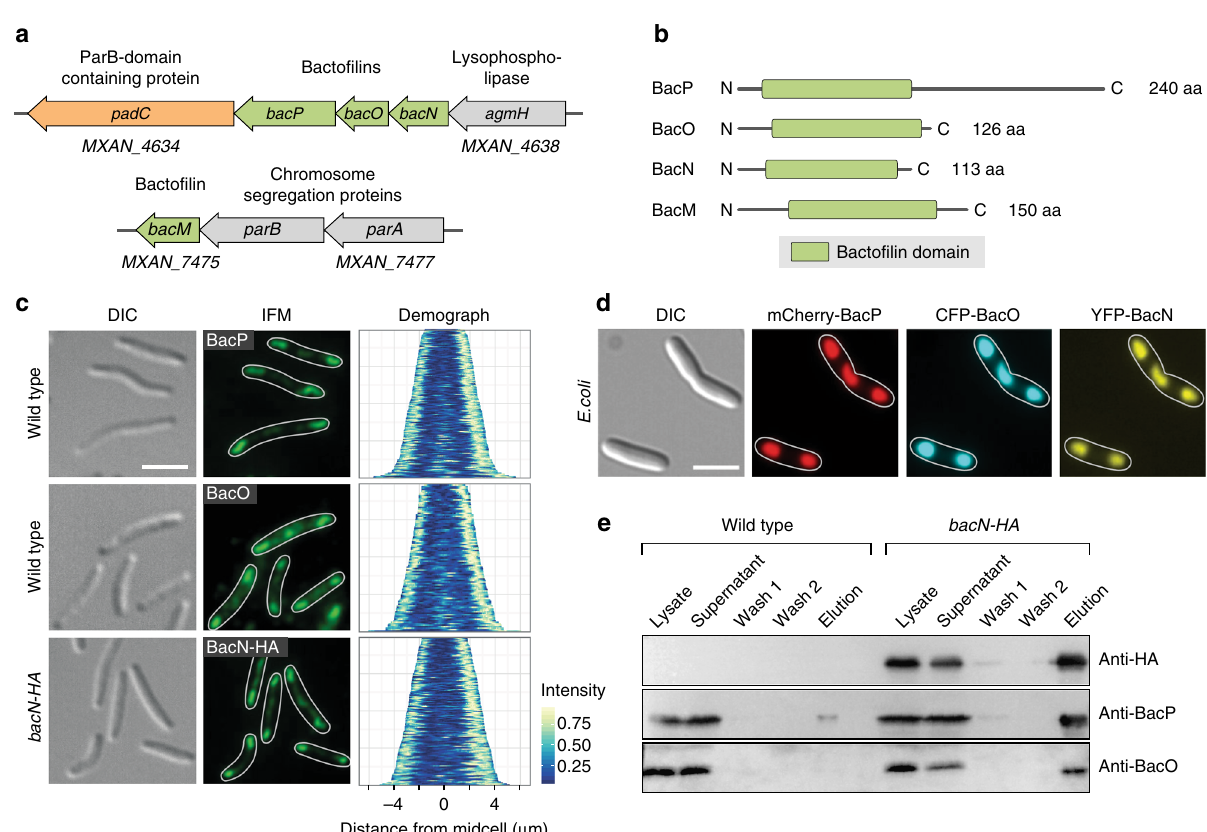
Fig. 1 BacNOP co-assemble into extended bipolar structures. a Chromosomal context of the four bacto fi lin genes ( bacM , bacN , bacO , and bacP ) present in the M. xanthus DK1622 genome. Arrows indicate the direction of transcription. b Domain organization of the M. xanthus bacto fi lin homologs. The bacto fi lin (DUF583) domain is shown as a green box. Disordered regions are represented by black lines. c Subcellular localization of BacP, BacO, and BacN-HA. Cells of strains DK1622 (WT) or LL033 ( bacN::bacN-HA ) were analyzed by immuno fl uorescence microscopy (IFM), using anti-BacP, anti-BacO (DK1622), or anti-HA (LL033) primary antibodies and an Alexa-Fluor 488-conjugated secondary antibody (bar: 3 µ m). In the demographs on the right, the fl uorescence pro fi les of individual cells were sorted according to cell length and stacked on each other, with the shortest cell shown at the top and the longest cell shown at the bottom ( n = 165 cells for BacP, 100 cells for BacO, and 150 cells for BacN-HA). d Heterologous reconstitution of the BacNOP complex in E. coli . E. coli strain Rosetta(DE3)pLysS bearing plasmids pLL54 (P T7 - mCherry-bacP e cfp-bacO ) and pPS20 (P tet -e yfp-bacN ) was induced with 0.5 mM IPTG (for 3.5 h) and 0.2 µ g/ml aTet (for 2 h) to stimulate the synthesis of fl uorescently tagged bacto fi lin variants. Cells were analyzed by differential interference contrast (DIC) and fl uorescence microscopy (bar: 3 µ m). The Pearson ’ s correlation coef fi cients (PCCs) for the patterns observed are 0.95 ± 0.04 (mCherry-BacP/ CFP-BacO, n = 119 cells) and 0.94 ± 0.06 (mCherry-BacP/YFP-BacN, n = 119 cells). Note that despite the use of the strong T7 and tet promoters,